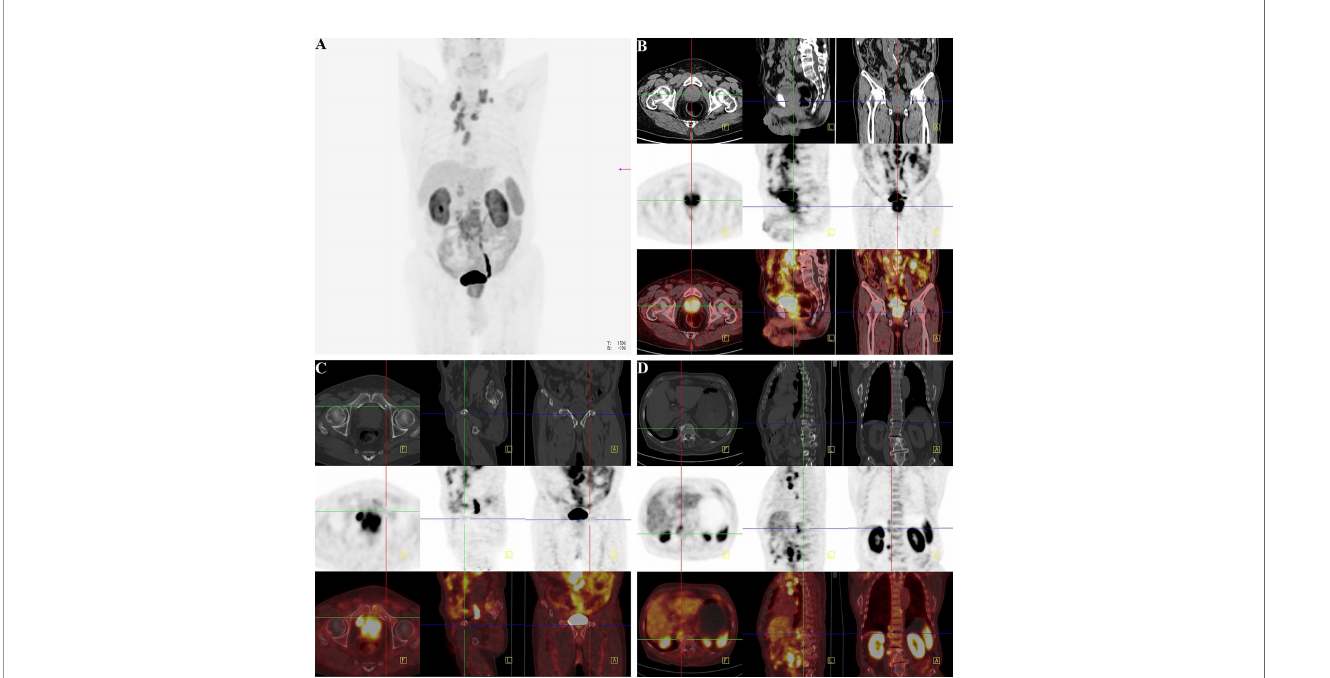
FIGURE 8 | 18 F-Alfatide II as the molecule probe of integrin a v b 3 revealed high intake in primary and metastatic lesions through the PET-CT detection in a case of 82- year-old man. (A) Gross appearance of coronary position detected by PET-CT. The darker the color was, the higher the intake of tracer in the corresponding body part. (B) The direction cross focused on the primary lesion in prostate. The fi rst row were CT views centered on high intake lesion of PCa from three different directions in the pelvis, which revealed the adjacent organs and structure. The second row were the PET-CT views detected by 18 F-Alfatide II as the molecule probe of integrin a v b 3 centered on high intake lesion of PCa from three different directions. As the main function of bladder should be storing urine and the tracer was discharged by urine, it was rational that there was darker high-intake region in the bladder. However, the abnormal area of high-intake tracer appearing in the prostate suggested high-level af fi nity of probe which might be closely correlated to malignant cancer. The third row was combined with the fi gures of the fi rst and second rows. The lighter the color shows the higher the intake of tracer in prostate. (C) The direction cross focused on the metastatic lesion in the middle part of the pubis from three differential directions. The fi rst row was the view of regular CT, which revealed the bone structure and surrounding tissues. There was an unusual small spot of osteoproliferation in the direction cross. The second row demonstrated the abnormal high-intake lesion of 18 F-Alfatide II in the left side of the middle part of the pubis, respectively, which was highly coincident with the “ unusual small spot ” , The third row was the combination of the fi rst and second row, which systematically reported the accurate location of metastatic lesion in pubis and relative extent of tracer intaking. (D) The direction cross focused on the metastatic lesion on the right side of the lumbar 1 vertebra. The fi rst row was regular CT view in the slice of abdomen. Compared with the adjacent vertebrae, the direction cross revealed high density in bone cortex, which was consistent with the characteristics of osteoblastic metastasis in PCa. In the second row, from the sight of 18 F-Alfatide II, except for the rich blood supply organs like kidneys, spleen, and liver, the strange high intake of probe in the vertebra presented metastatic lesion. In the third row, the emerge of both fi rst and second rows in the same slice then provided the reliable evidence of metastatic lesion form the aspects of position and signal